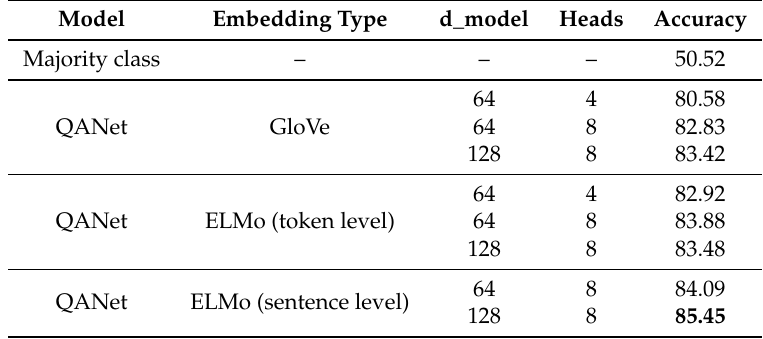
Table 2. Auxiliary task: question–answer goodness classification results.